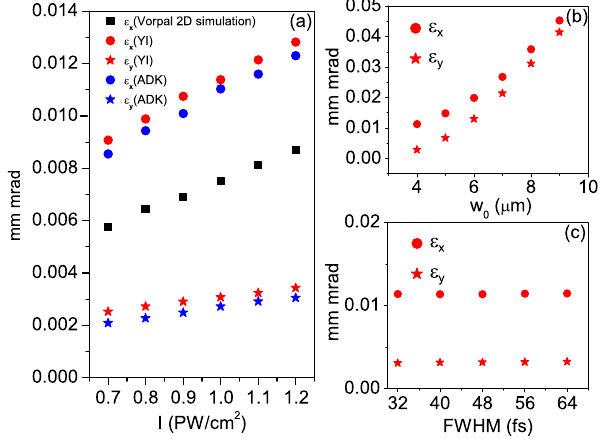
FIG. 5. Laser pulse parametric study of emittance. The plot (a) displays the increase of emittance with laser intensity both in x direction (dot) and in y direction (star). ADK theory (blue) and YI model (red) are compared with results from VORPAL simula- tion (black square). Note that (cid:3) y is excluded due to 2D simula- tion. At a fixed intensity of I ¼ 1 PW = cm (cid:1) 2 , the top and bottom plots on the right show effects of beam waist w 0 and pulse duration FWHM on emittance, respectively.